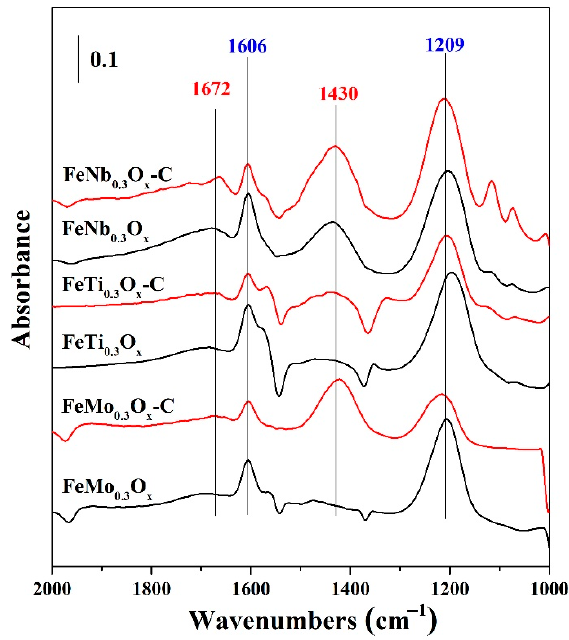
Figure 4. In situ DRIFTS of adsorption of NH 3 species over all the FeM 0.3 O x -C and FeM 0.3 O x (M = Nb, Ti, Mo) samples at 150 °C. Before measurement, each sample was pretreated in 500 ppm NH 3 /N 2 for 0.5 h and then purged by N 2 for 0.5 h.